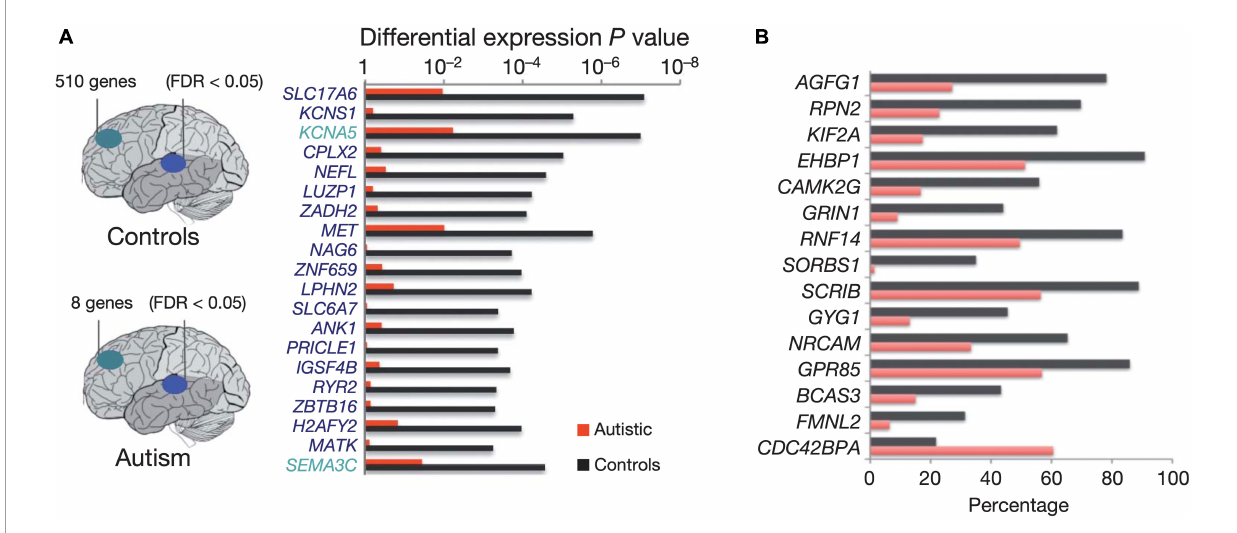
FIGURE4 Diagram depicting the number of genes showing significant expression differences between frontal and temporal cortex in control samples (top) and autism samples (bottom). (A) Top 20 genes differentially expressed between frontal and temporal cortex in control samples. All of the genes shown are also differentially expressed between frontal and temporal cortex in fetal mid-gestation brain, but show no significant expression differences between frontal and temporal cortex in autism. The horizontal bars depict p values for differential expression between frontal and temporal cortex in the autism and control groups. (B) Top A2BP1 (RBFOX1) -specific differential splicing (DS) events. DS events showing the most significant differences in alternative splicing between low-A2BP1 autism cases and controls as well as DS differences consistent with the A2BP1 binding site position. The horizontal axis depicts the percentage of transcripts including the alternative exon. Red-autism samples, black-control samples Figure modified from Voineagu et al. (2011) obtained by Springer Nature under license No 5430811097703 and